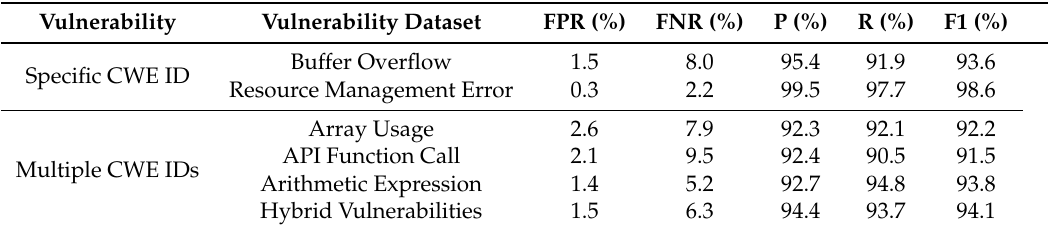
Table 6. Comparison of different classification